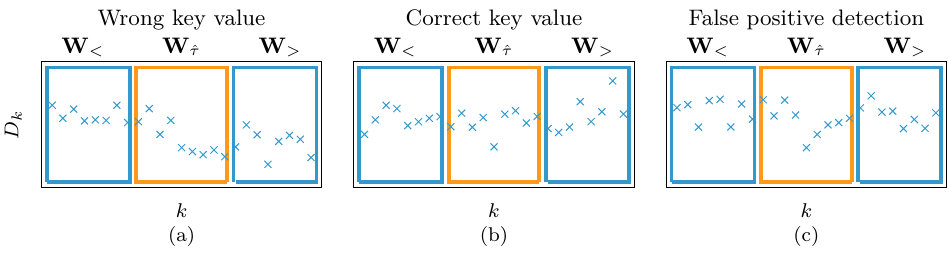
Figure 2: Examples of distinguisher values contained in the windows W ˆ τ , W < , W > and the rationale behind our correction procedure. In (a) the key value tested in W ˆ τ is wrong, thus W < and W > have different distributions. In (b), the tested key value is correct, thus W < and W > follow the same distribution. In (c), ˆ τ is a false positive detection, thus the distributions of W < and W > coincide, but this is different around the detection, i.e. in W ˆ τ . This latter illustration indicates why it is necessary not to include W ˆ τ in the error correction, and also to remove this window from D when the monitoring